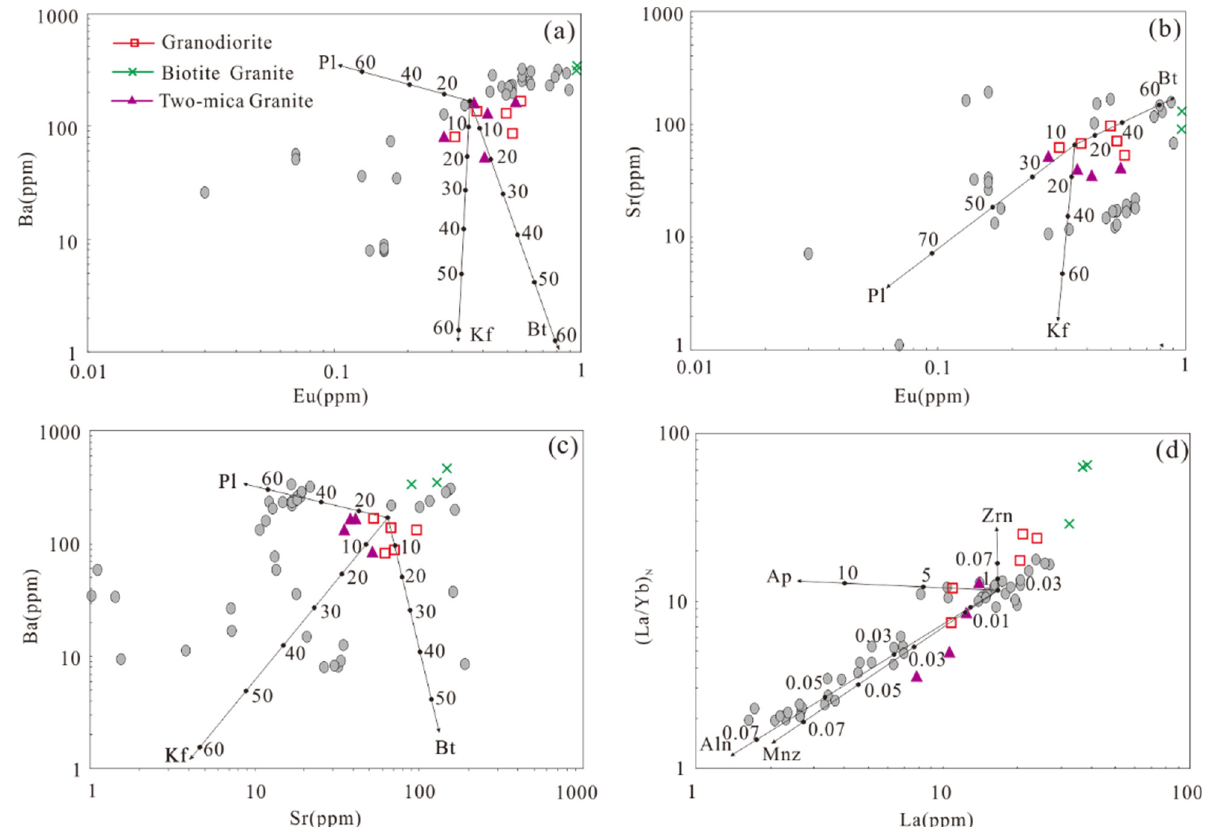
Figure 9. ( a ) Ba vs. Eu, ( b ) Sr vs. Eu, ( c ) Ba vs. Sr, and ( d ) (La/Yb) N vs. La diagrams of the Zhuxi granites. Partition coefficients of Ba and Sr are from [82], Eu is from [83], apatite is from [84], zircon and allanite are from [85], and monazite is from [86]. Abbreviations: Pl—plagioclase;